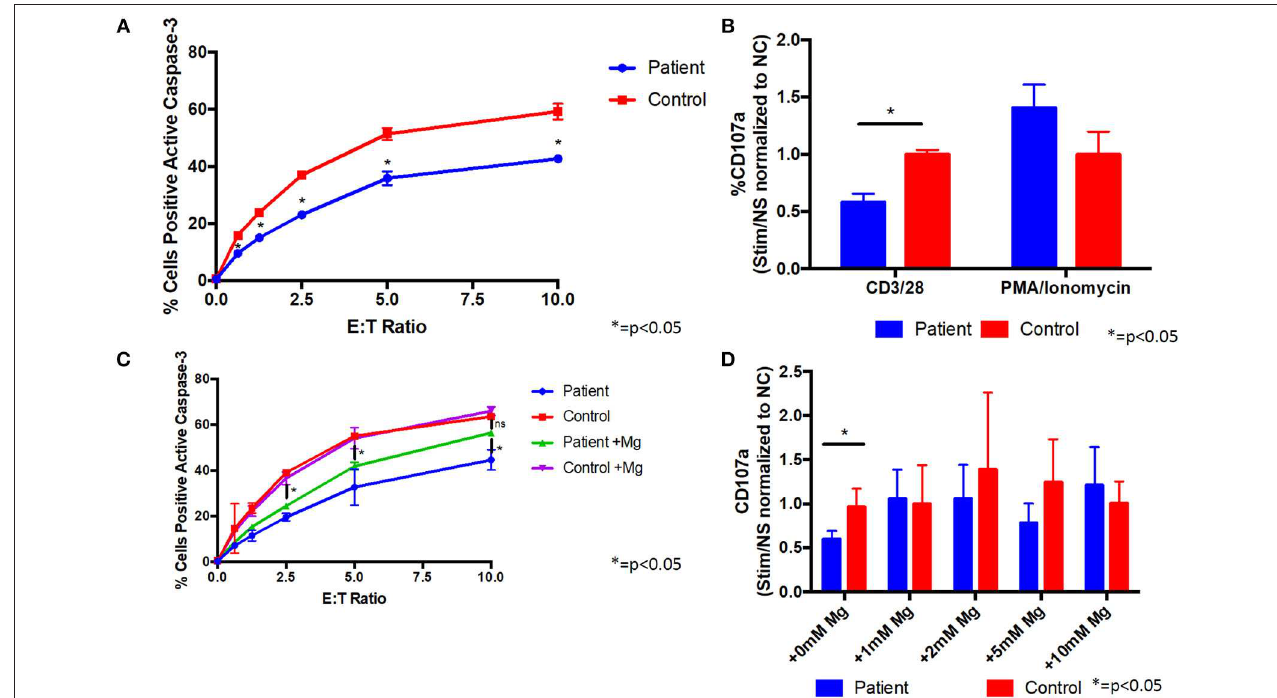
FIGURE 3 | Supplemental magnesium restores impaired degranulation and cytotoxicity associated with T cell signaling in vitro in cells from a patient with homozygous ITK mutations. (A) Cytotoxicity is impaired in CD8 + cells from the patient compared to CD8 + cells from a healthy control. Patient or healthy control CD8 + cells were incubated with L1210 murine cells with anti-CD3 and anti-Fas antibodies. Cytotoxicity was measured by flow cytometry as the percentage of L1210 cells positive for active caspase-3. E:T ratio is the effector cell to target cell ratio. Data represent mean ± standard deviation (SD). (B) Degranulation is impaired in CD8 + cells from the patient following CD3/CD28 stimulation. Prior to stimulation with anti-CD3/CD28 antibodies, anti-CD107a antibody (a marker of degranulation) was added to cells from the patient or healthy normal control (NC). Following stimulation, patient and control cells positive for CD107a were measured by flow cytometry. Degranulation was quantified as the fold change of the percent of CD107a positive cells from the stimulated (Stim) to non-stimulated (NS) samples and normalized to the healthy control. PMA/ionomycin was used as a positive control, which shows similar degranulation in patient and control cells. Data represent mean ± SD. (C) Cytotoxicity in CD8 + cells following culture with 1mM supplemental magnesium (Mg) or no additional magnesium. Data represent mean ± SEM. (D) Degranulation when patient and healthy control cells were cultured in supplemental Mg for 5 days. Data represent mean ± SD. (A–D) Asterisk indicates p < 0.05. anti-CD3, anti-CD28, and anti-CD107a antibodies were from Biolegend, PE-anti-caspase 3 antibody was from BD Bioscience, and anti-Fas antibody was from Millipore. All experiments were repeated two to four times and pooled data are